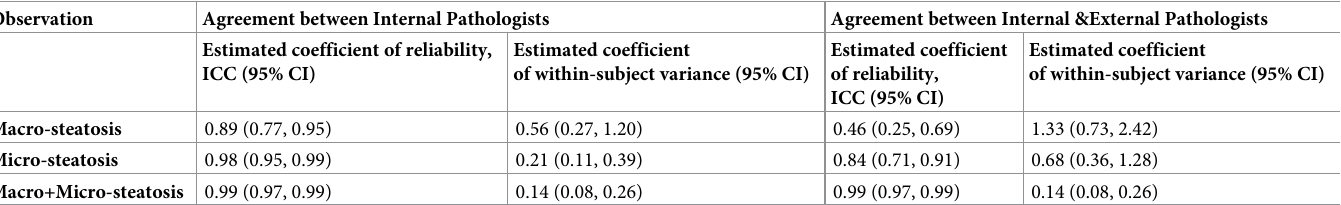
Table 2. Interclass correlation coefficient for Histology reading by two independent